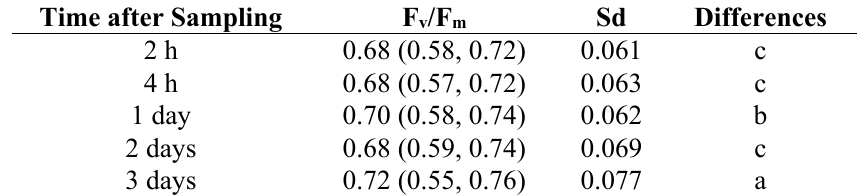
Table 2. Average Photosystem II maximal quantum yield (F v /F m ) after transfer of cut leaves of 30 barley genotypes acclimated in the field to the laboratory (E3). n = 180 = 6 leaves per genotype × 30 genotypes. F v /F m mean with lowest and highest genotype mean in parentheses. Sd = Standard deviation of the full set of all single measurements. Significant differences between sampling times tested with Wilcoxon rank sum